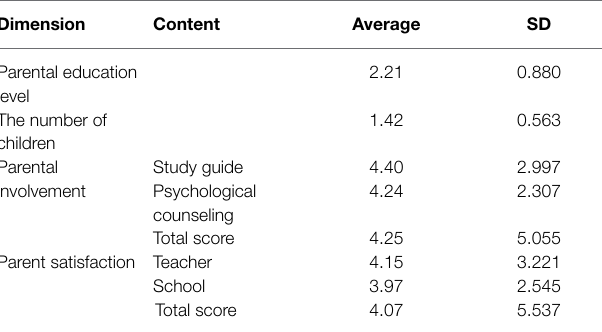
TABLE 1 | Descriptive statistics. TABLE 2 | Comparison of each dimension